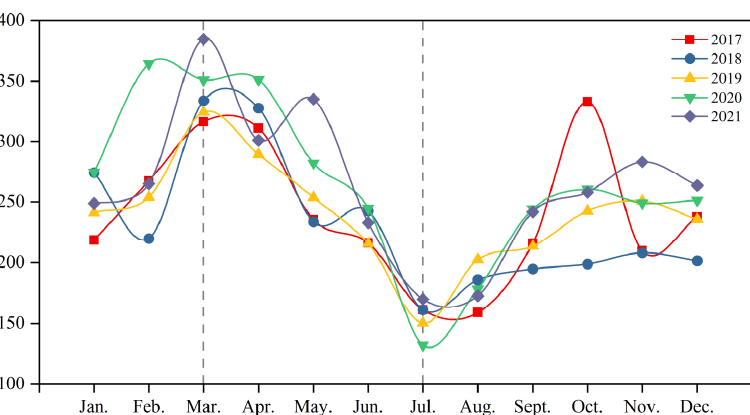
Figure 5. Global monthly organic carbon losses from farmland, 2017–2021. In contrast to dust emissions, organic carbon losses are influenced by both dust emissions and the regional weight percentage of organic carbon in farmland soil. This makes variations in organic carbon losses from day to day relatively smooth at a global scale (Figure 6), although regional differences in the weight percentage of organic carbon in farmland soil are not particularly large. Global organic carbon loss, like the dust emissions that influence it, has multiple peaks from January to April, when there are generally one to four days a month with spikes, and from October to December, when there are spikes around two to three days each month. In the crop-growing months in the middle of the year, day-to-day organic carbon loss does not fluctuate much and is less variable than dust emissions.